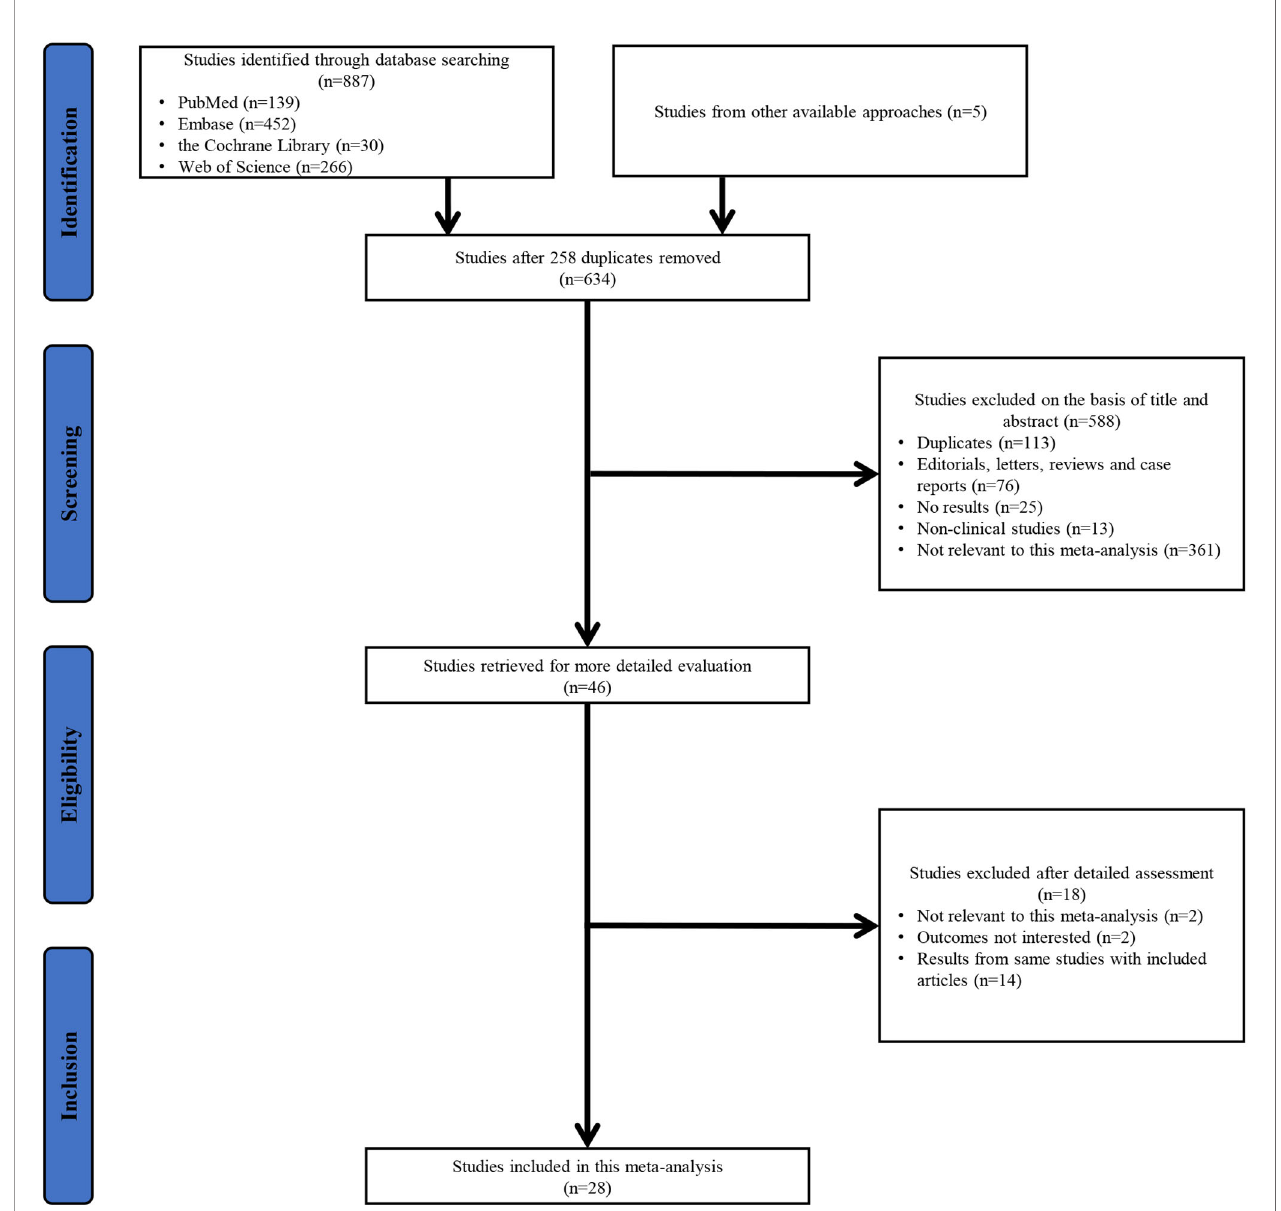
FIGURE 1 | PRISMA fl owchart of the study selection process. PRISMA, Preferred Reporting Items for Systematic Reviews and